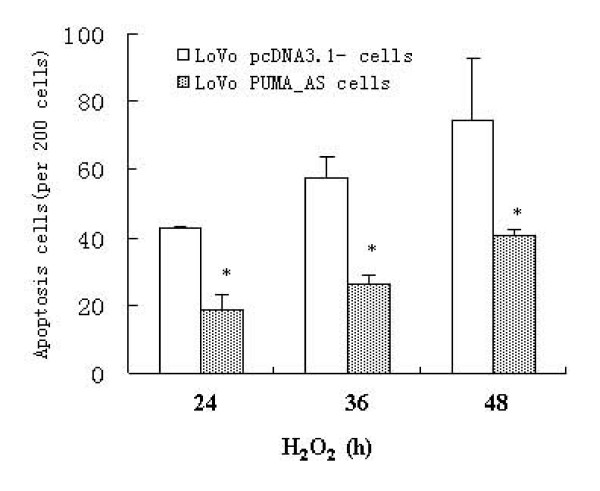
Suppression of PUMA expression abrogated the apoptosis induced by H2O2. LoVo PUMA wild-type cells and LoVo PUMA_AS cells were treated with H2O2 (0.64 mM) for 15 minutes and allowed to recover for 24 hours. Hoechst dye 33258 was used to detect apoptosis. Data are presented as mean number of apoptotic cells (mean ± SD) from three independent experiments. Significant difference between LoVo PUMA wild-type cells and LoVo PUMA_AS cells is indicated by * (p < 0.05).